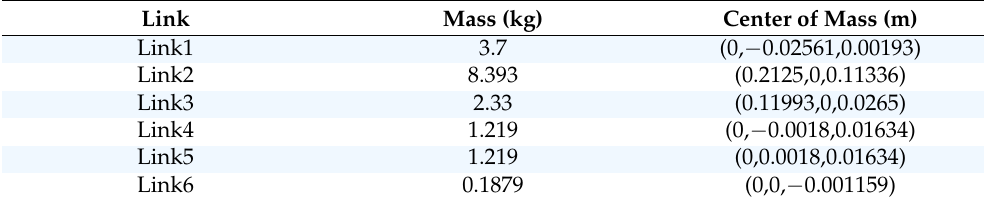
Table 2. Dynamic parameters of the UR5